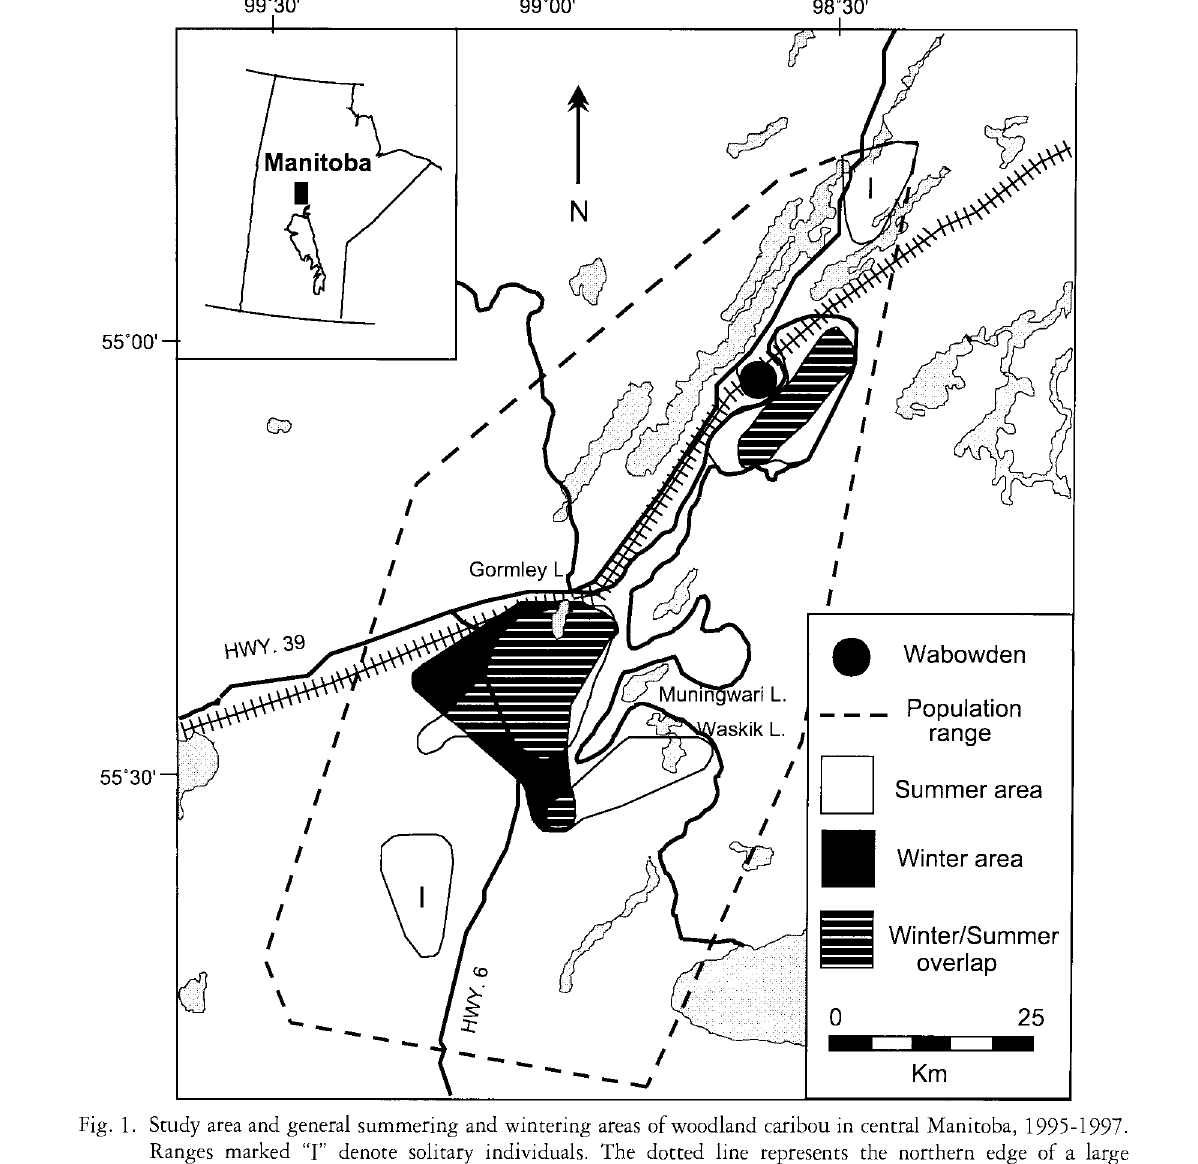
Fig. 1. Study area and general summering and wintering areas of woodland caribou in central Manitoba, 1995-1997. Ranges marked "I" denote solitary individuals. The dotted line represents the northern edge of a large contiguous peatland